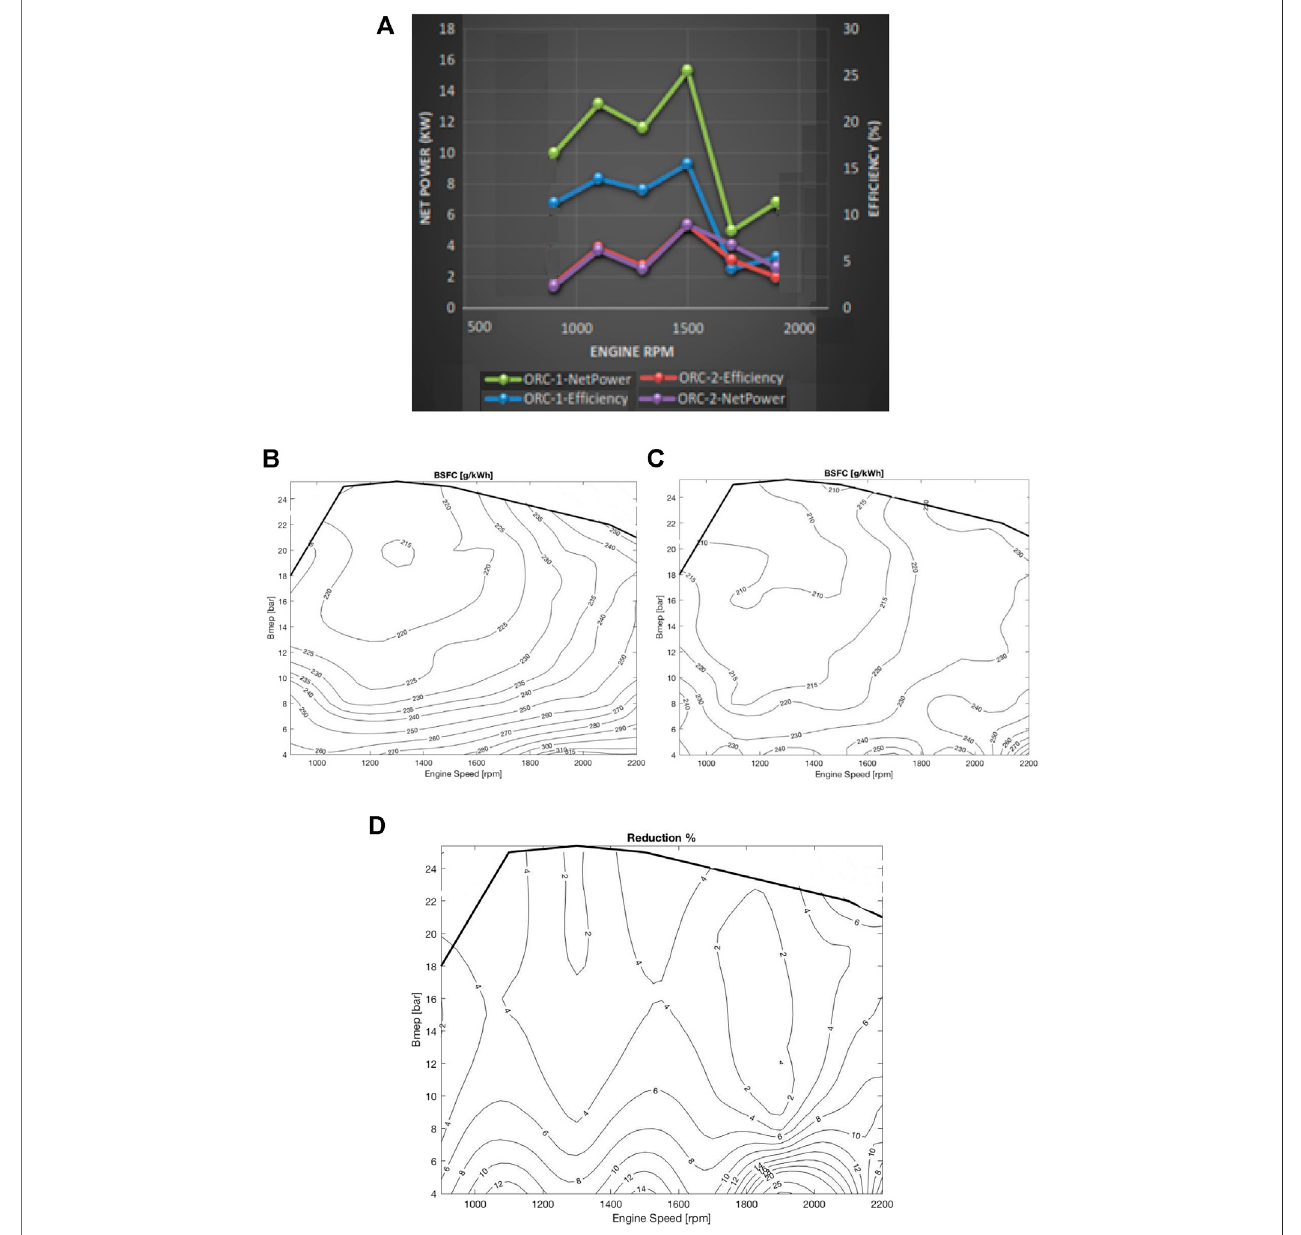
FIGURE 11 | (A) Comparison of ORC systems, (B) BSFC map without and (C) with ORC system; (D) percentage of BSFC reduction with ORC installed on modelled HDD engine.